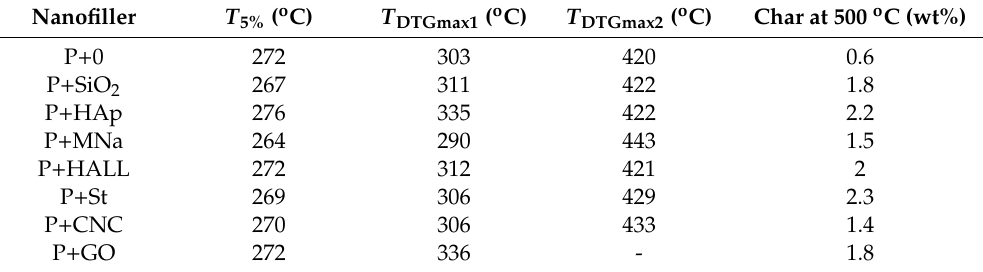
Table 3. Thermal properties of the PUU matrix and the nanocomposite films.